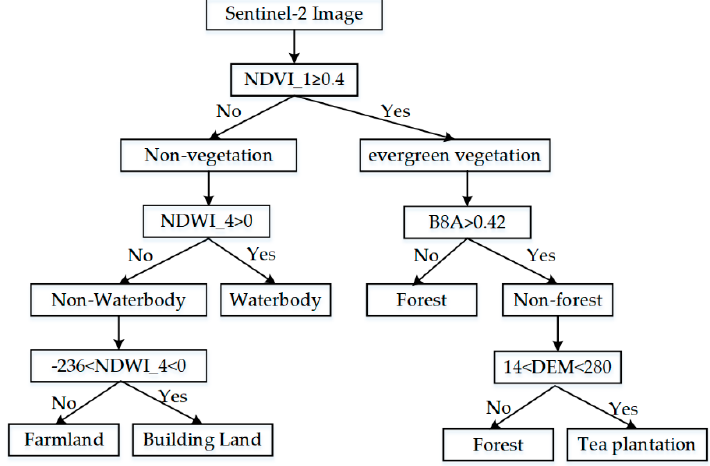
Figure 2. Schematic diagram of decision tree